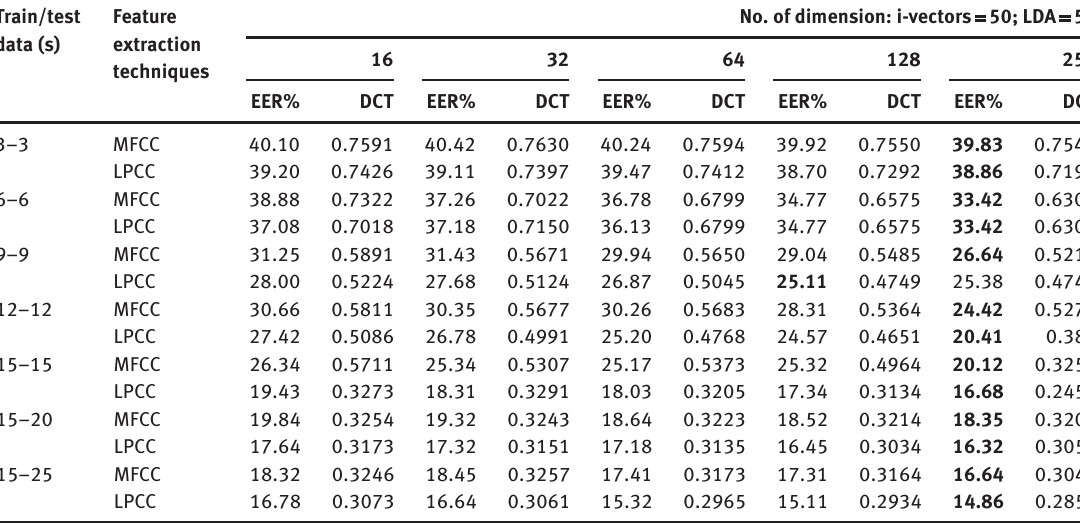
Table 5: EER of Speaker Verification Using the NIST 2003 database for Different Feature Extraction Techniques (39 Dimensions) and Modeling Done by i-Vectors.